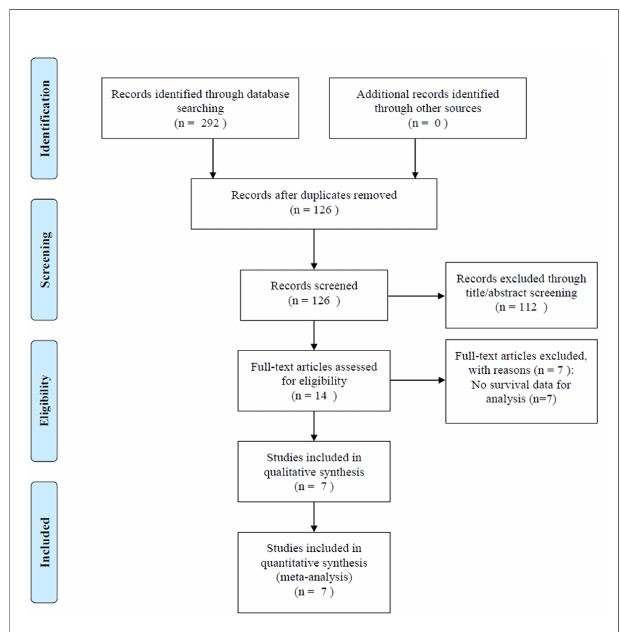
FIGURE 1 | Flowchart describing the literature search and study selection.